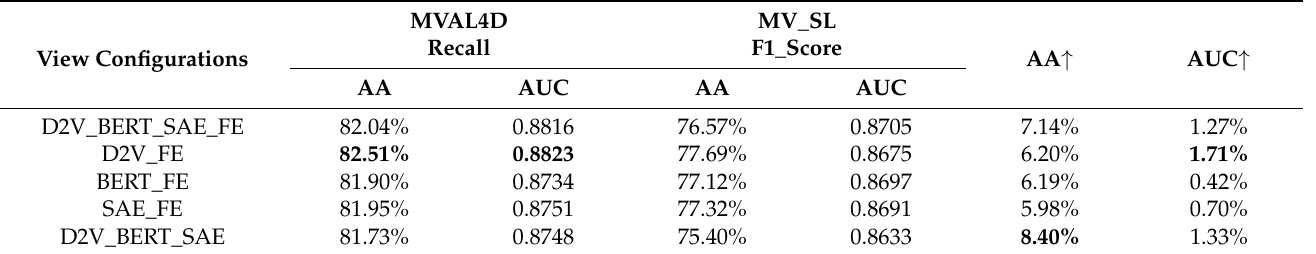
Table 4. Performance of the proposed approach with different view